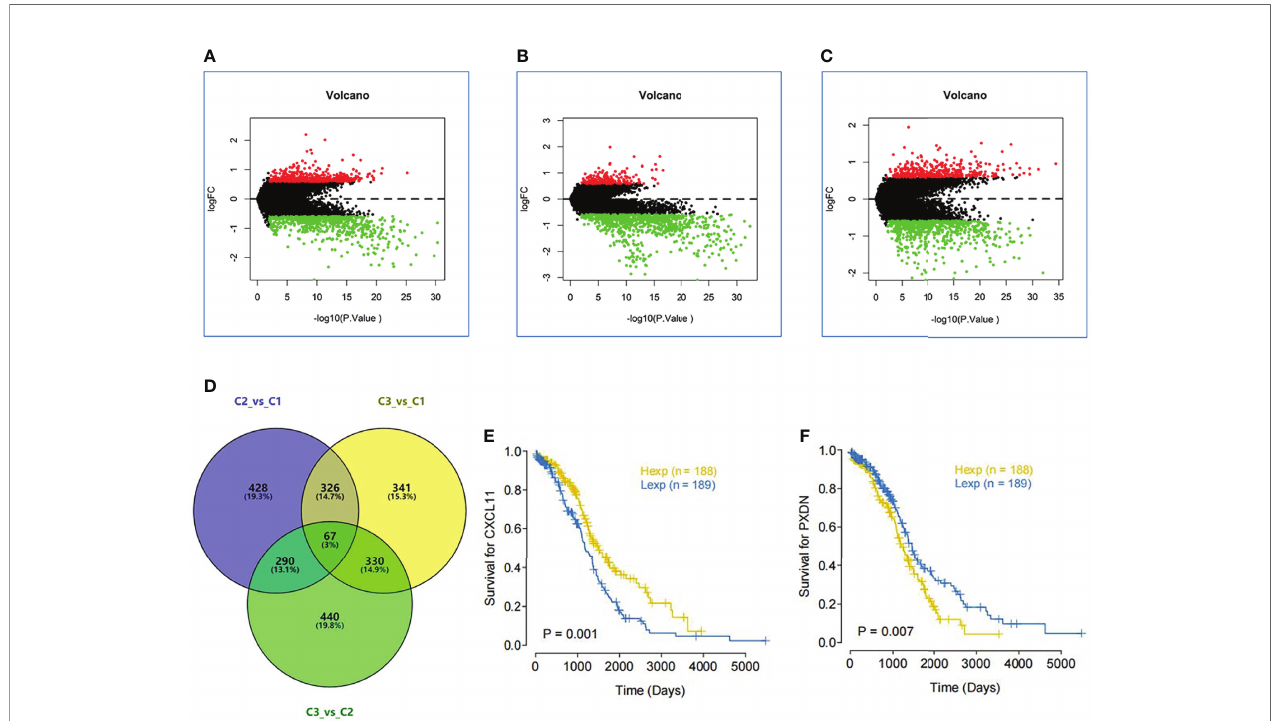
FIGURE 7 | Signi fi cant difference gene analysis. (A) Different expression analysis among subgroups C1 vs C2. (B) Different expression analysis among subgroups C3 vs C1. (C) Different expression analysis among subgroups C3 vs C2.(|log 2 FC| > 0.585 and. p value < 0.01). (D) Wayne analysis shows mount of different expression gene in three subgroups. (E) The survival curve of the different expression of CXCL11. (F) The survival curve of the different expression of